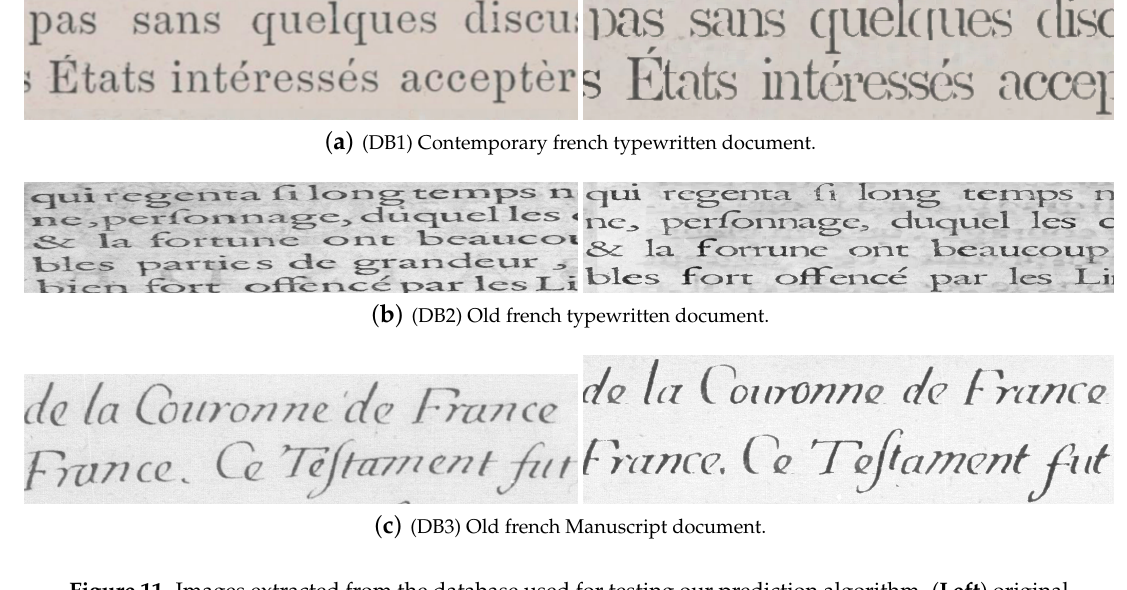
Figure 11. Images extracted from the database used for testing our prediction algorithm. ( Left ) original images. ( Right ) synthetic generated images.